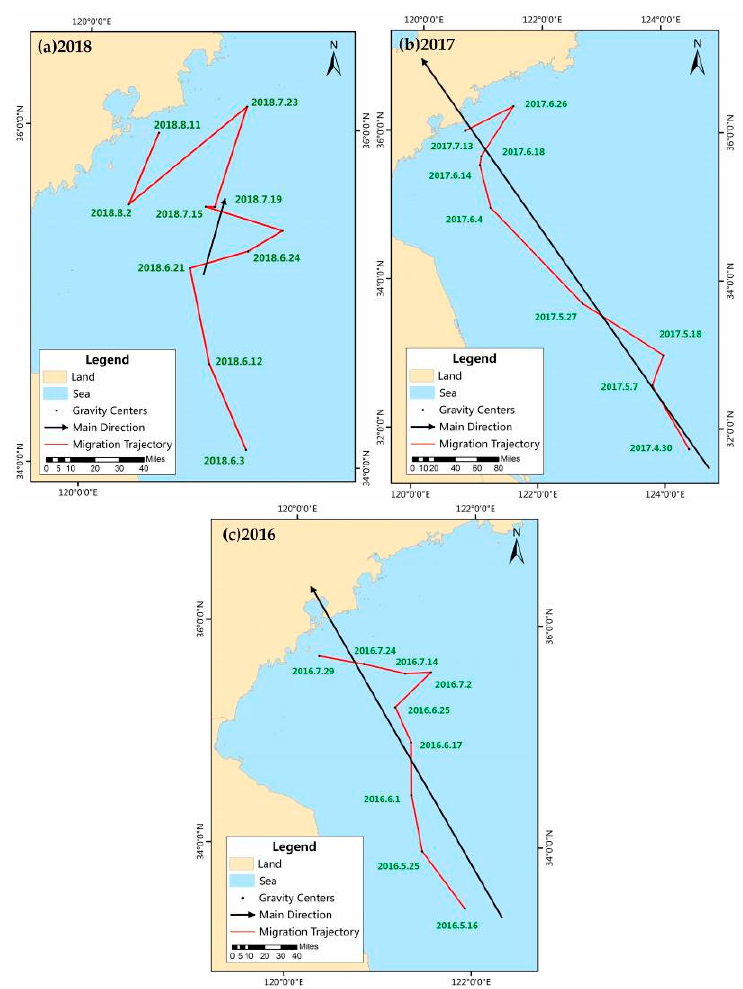
Figure 8. ( a ) Migration trajectory of the average barycenter in 2018. ( b ) Migration trajectory of the average barycenter in 2017. ( c ) Migration trajectory of the average barycenter in 2016. The direction of the black arrow in three graphs indicates the main direction of the path, and the length of the line represents the path length and the consistency of the subpaths, to some extent. Generally speaking, the longer the migration path is, the more consistent the direction trend of the subpaths is, and the longer the length of the main direction line is.